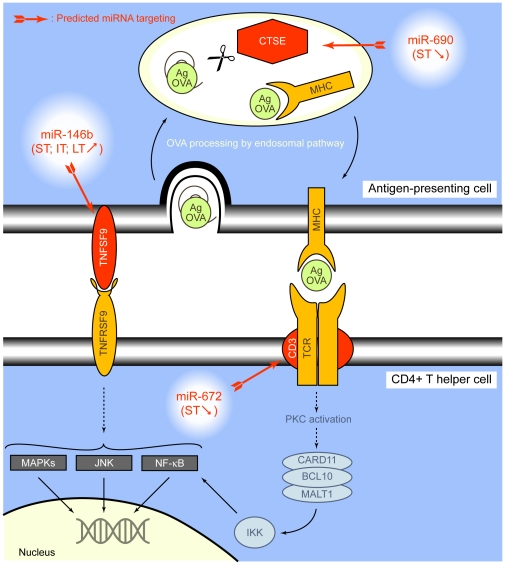
Potential influence of miRNAs on immune response induced by OVA.In antigen presenting cells, MHC complexes are maturated in endosomes by lysosomal reductases while CTSE processes antigen (Ag), i.e. OVA. Finally, the MHC/antigenic peptide complex translocates to the plasma membrane and is presented to the TCR/CD3 complex on CD4+ T helper cell surface. Activation of TCR/CD3 induces the activation of NF-κB through PKC activation and CARD11/BCL10/MALT1 complex recruitment. MiRNA modulation could occur through mmu-miR-690, -672 and -146b. Cross-linking of costimulatory receptors on the T helper cell with corresponding ligands, such as TNFRSF9 with TNFSF9, also induces NF-κB and regulators (MAPKs, JNK) of the activity of multiple transcription factors. Production of TNFSF9 could be under the control of mmu-miR-146b, thus regulating the T helper cells properties. ST, IT, LT: short, intermediate and long-term treatments, respectively. The observed up- (<$>\raster="rg1"<$>) and down- (<$>\raster="rg2"<$>) regulations of the expression of some specific miRNAs are reported.